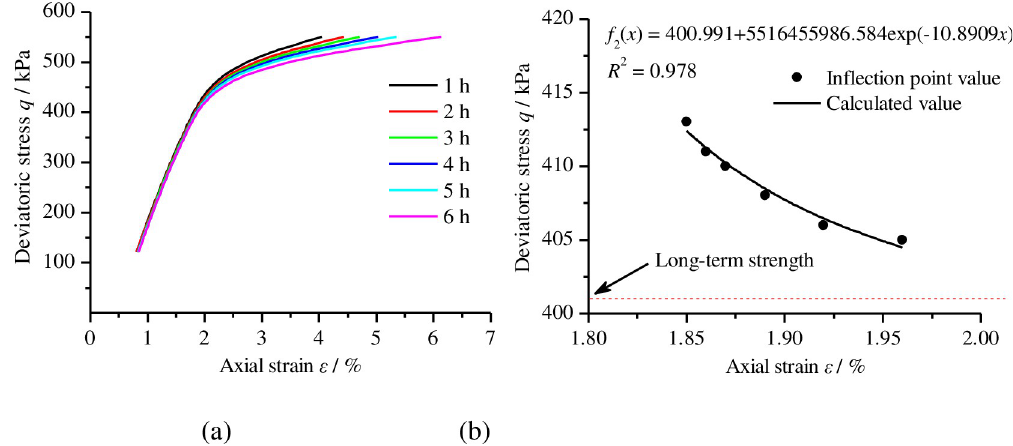
Fig 9. The long-term strength of remoulded loess is determined by isochronous stress-strain curves. (a) Isochronous stress-strain curves of the sample under compactness of 0.95; (b) the long-term strength was obtained by fitting the inflection point of the isochronous stress-strain